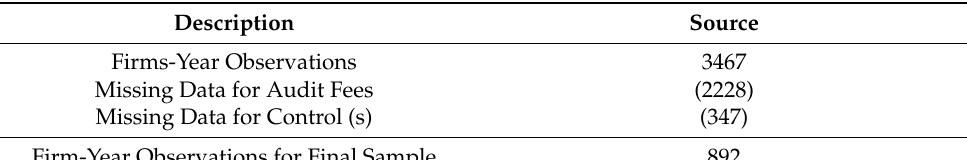
Table 1. Derivation of